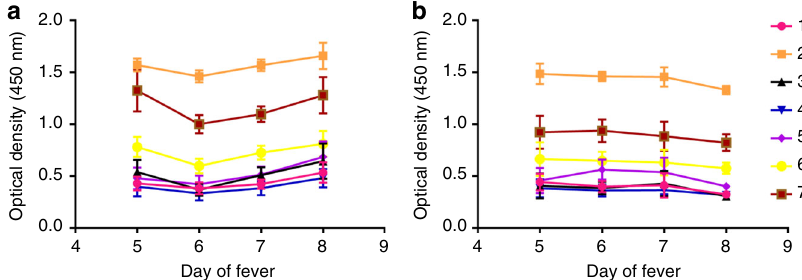
Fig. 7 NS1 antibody responses to selected regions of NS1. Antibody levels were measured in ten patients with DF ( a ) and ten patients with DHF ( b ), with acute secondary DENV1 infection throughout the course of illness to seven pools of selected NS1 overlapping peptides. Pool 1 represents aa 1 – 33, pool 2